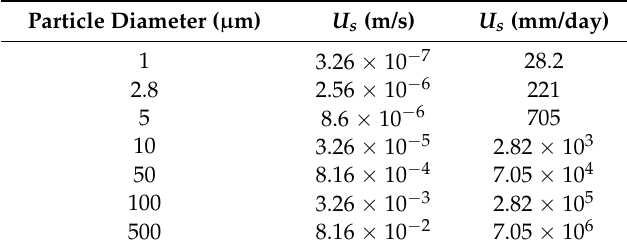
Table 1. Different particle settling velocities ( U s ) as a function of the particle diameter, from Equation (2). Here, we consider ρ p = 1.6 g/cm 3 (polystyrene), ρ f = 1 g/cm 3 and µ = 1.002 mPa s